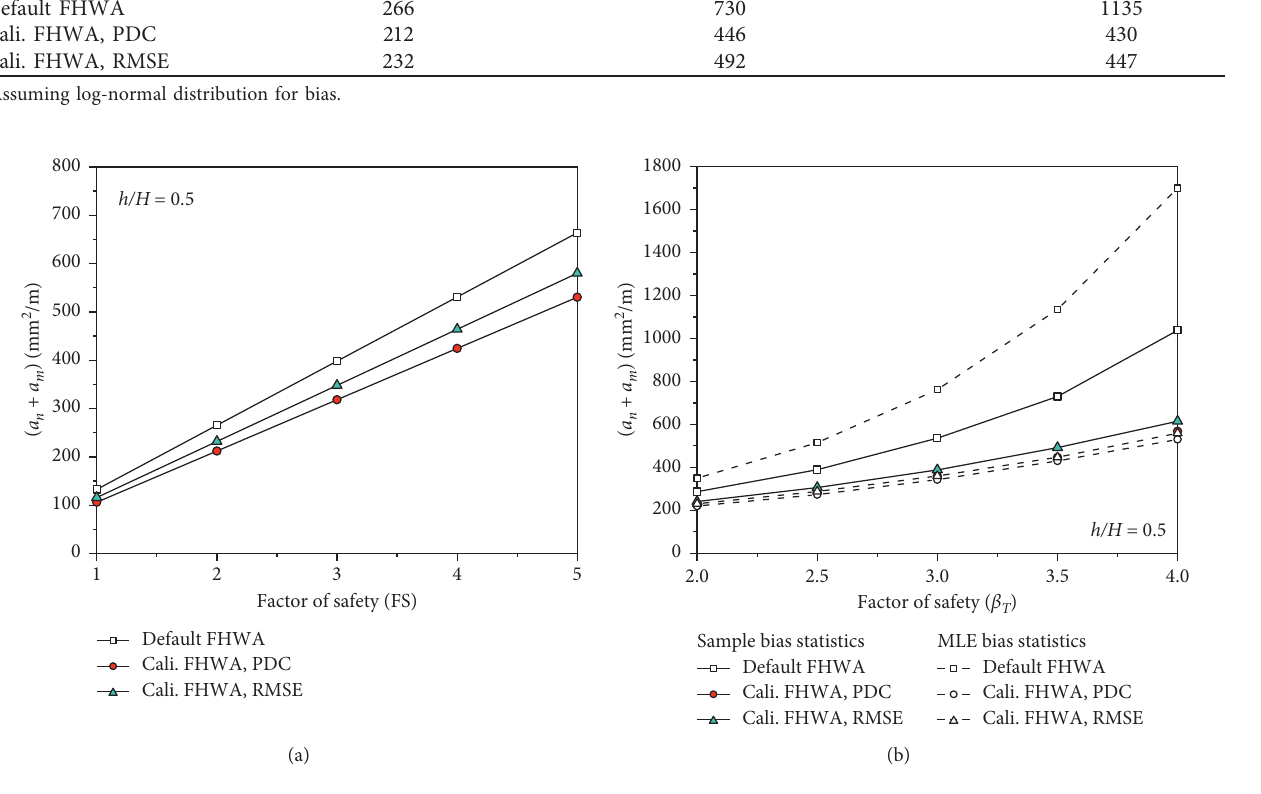
T ranging from 2 to 4.